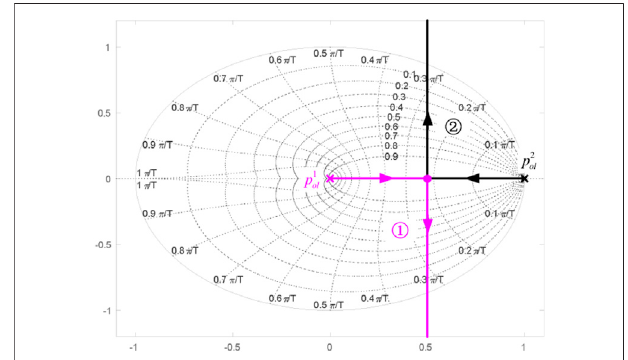
FIGURE 10 | Root locus diagram of the voltage loop with the employment of the developed